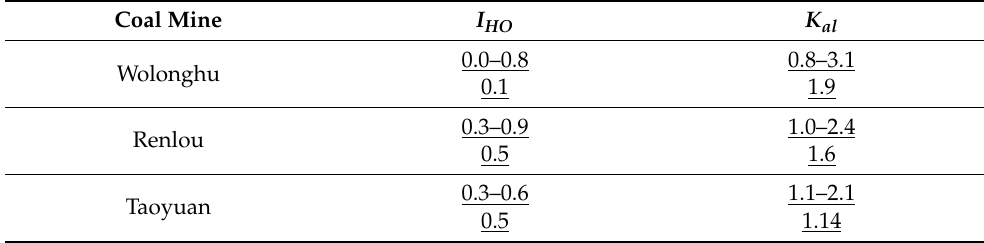
Table 3. Infrared spectrum parameters of selected coal samples in Huaibei Coalfield.